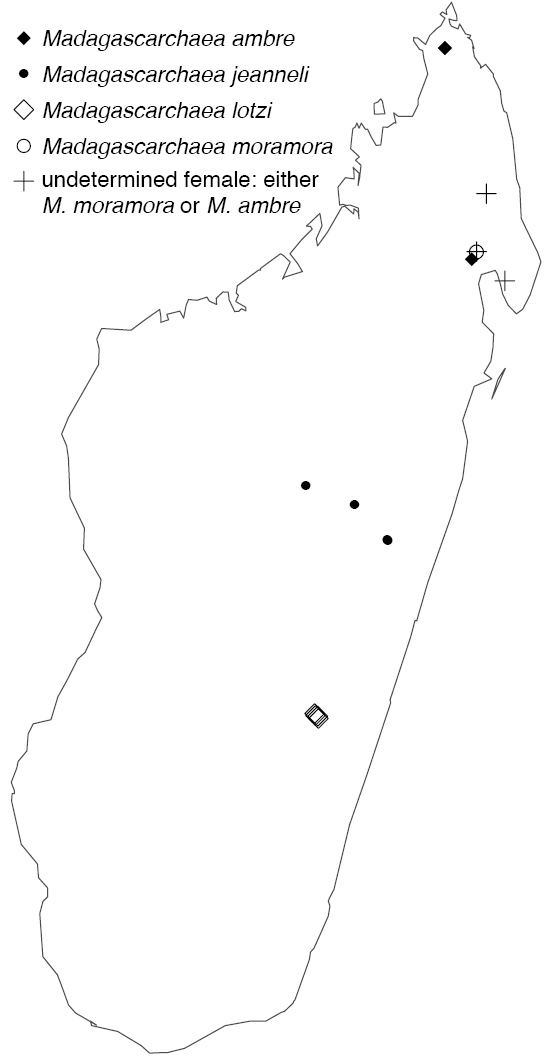
Distribution map for Madagascarchaea species.